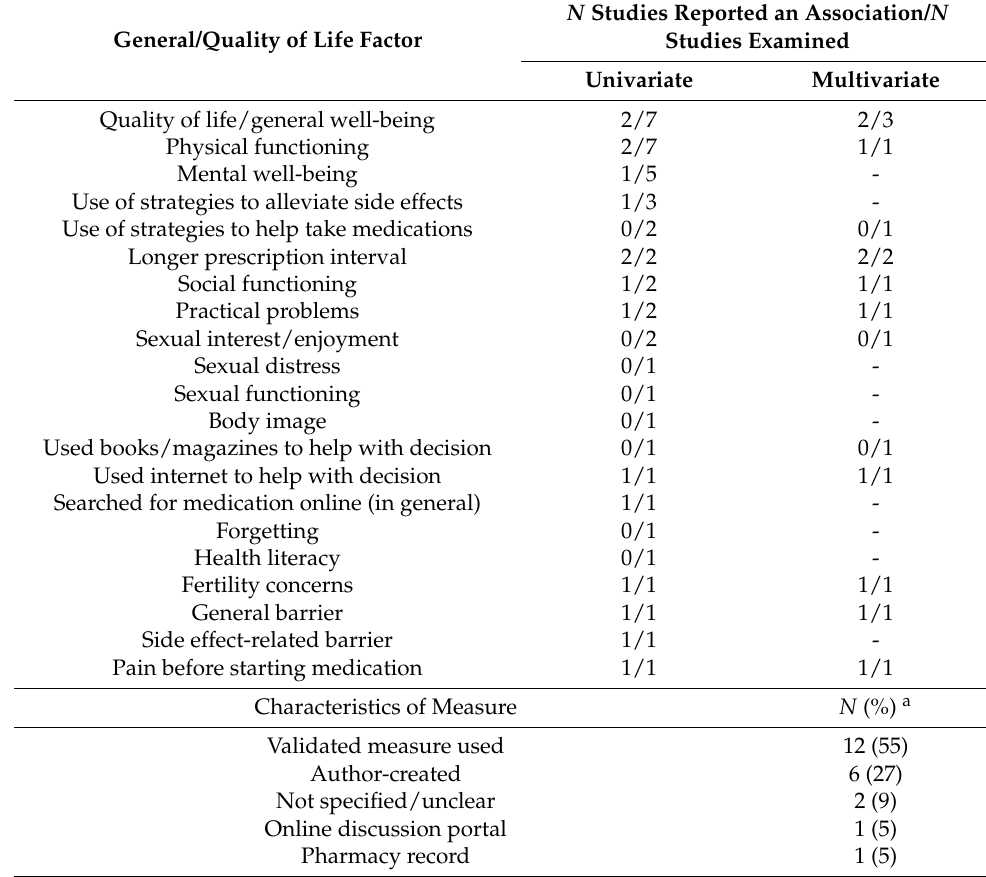
Table 8. Characteristics of studies that measured general and quality of life factors ( N = 24). General/Quality of Life Factor